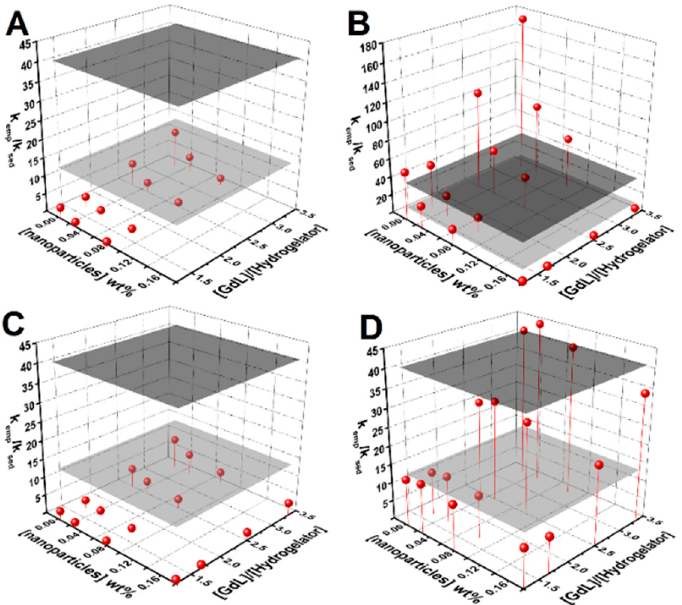
Figure 3. Surface plots of k emp /k sed dependence on nanoparticle concentration and the GdL-to-hydrogelator concentration ratio for: ( A ) bare nanoparticles, ( B ) the citrate-stabilized nanoparticles aggregation rate, ( C ) the sedimentation rate, and ( D ) lipid-coated nanoparticles. The gray planes define the estimated k emp /k sed required to guarantee that when the gel is about 10% of gelation completion, 90% of the nanoparticles remains in suspension ( ν = 1, a = 0.5, dark gray plane; ν = 0.5, a = 0.5, gray plane).